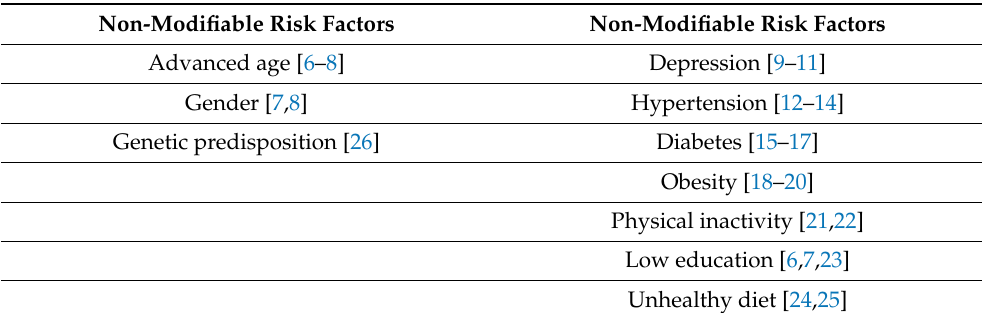
Table 1. Modifiable and non-modifiable risk factors for Alzheimer’s